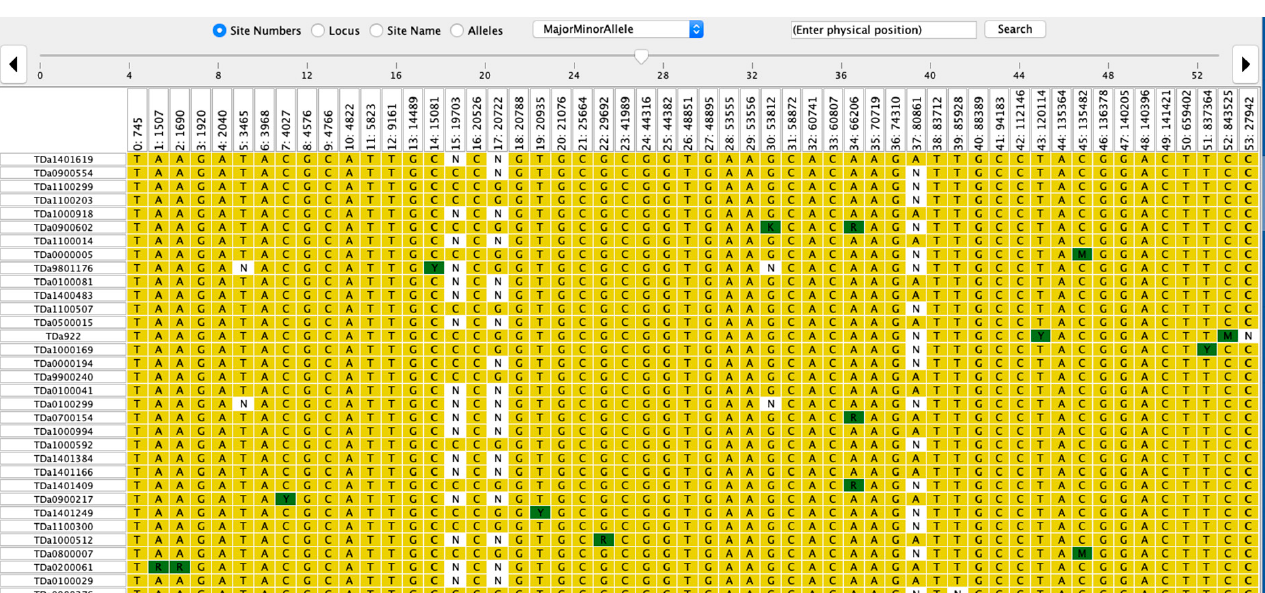
Figure 4. Female haplotype view for plant sex markers in D. alata. Yellow color refers to homozygosity while the dark green color indicates heterozygosity of the clone for the particular marker haplotype. The white color is associated with missing SNP markers information. TDa stands for Tropical D. alata and the number following TDa is a mention of the breeding code or accession number in the yam breeding program or the IITA Genetic Resource Center. The variable row represents the 54 sex markers identified by GWAS.